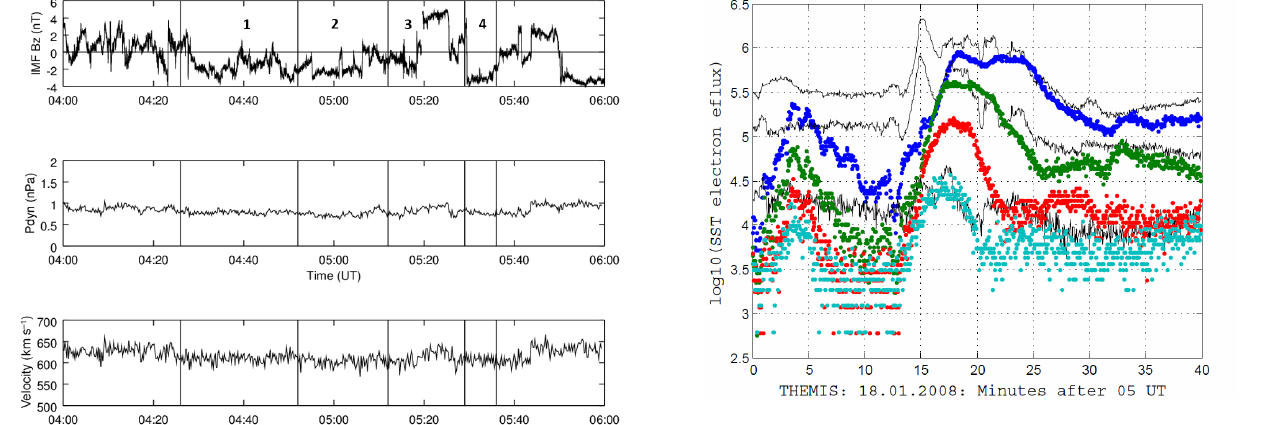
Figure 11. THEMIS P5 and P2 measurements of electron number flux. P5 measurements for channels 90, 134, and 279keV are shown with thin black lines (MLT ∼ 23). P2 measurements for channels 90, 134, 195, and 279keV are shown with blue, green, red, and cyan dots (MLT ∼ 02). The weakening of Pc5 pulsations (05:00– 07:00MLT) took place during